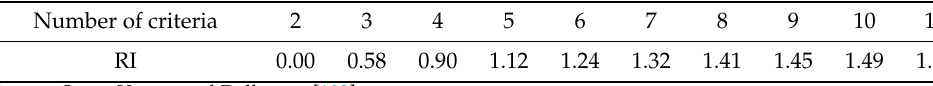
Table 3. Random index (RI) matrix of the same